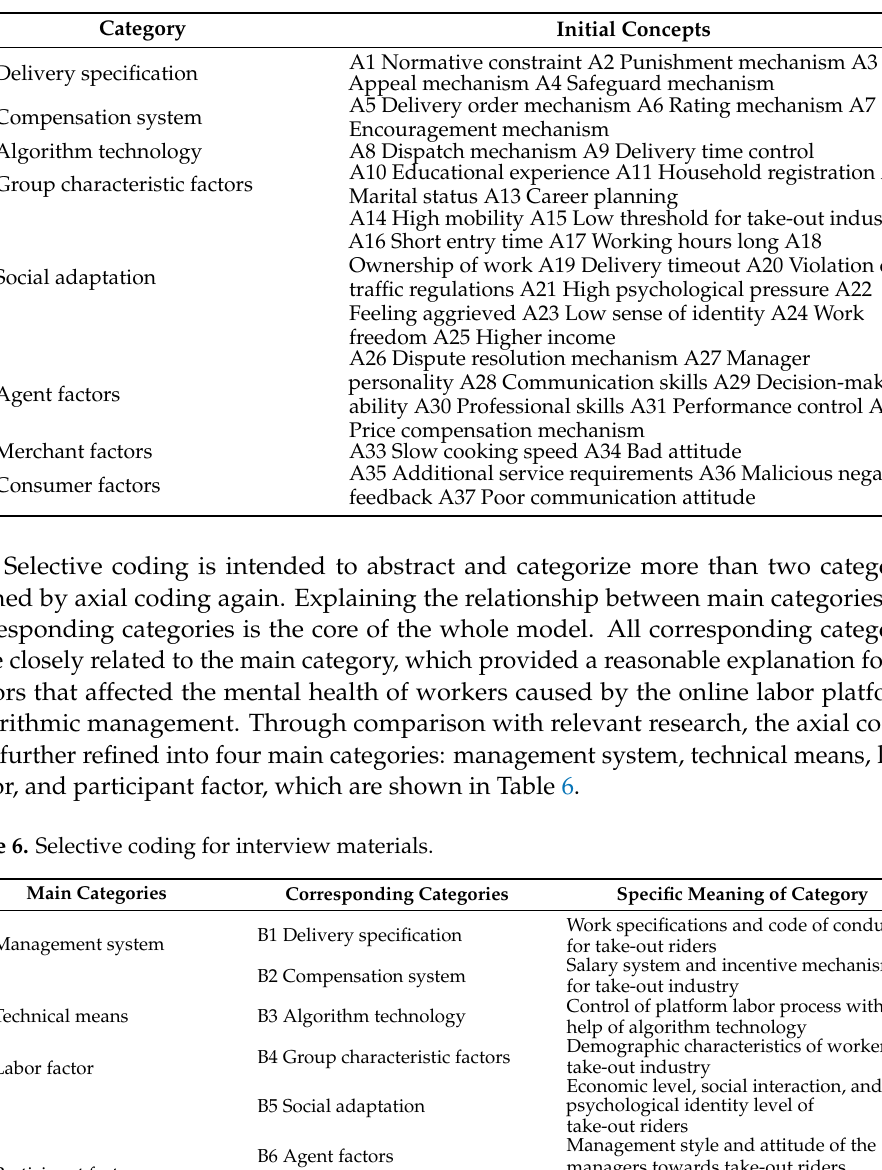
Table 5. Axial coding for interview materials.